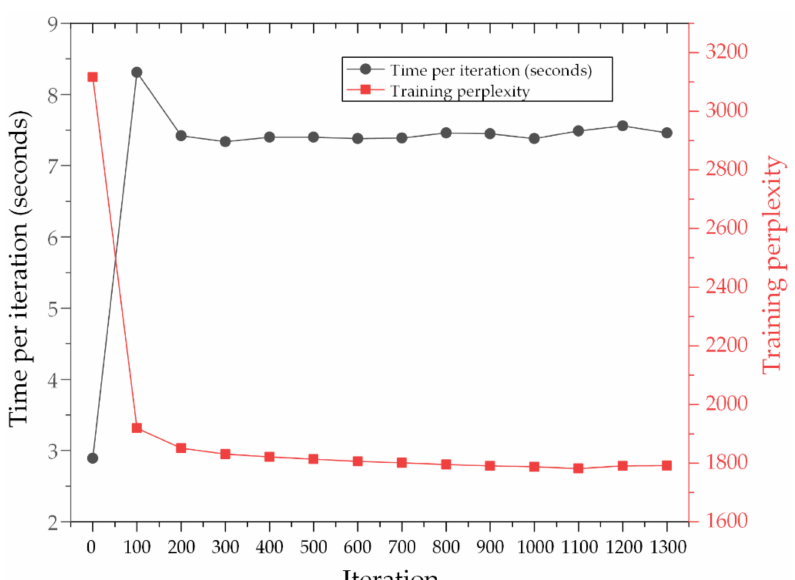
Figure 2. Effect of iteration times on machine